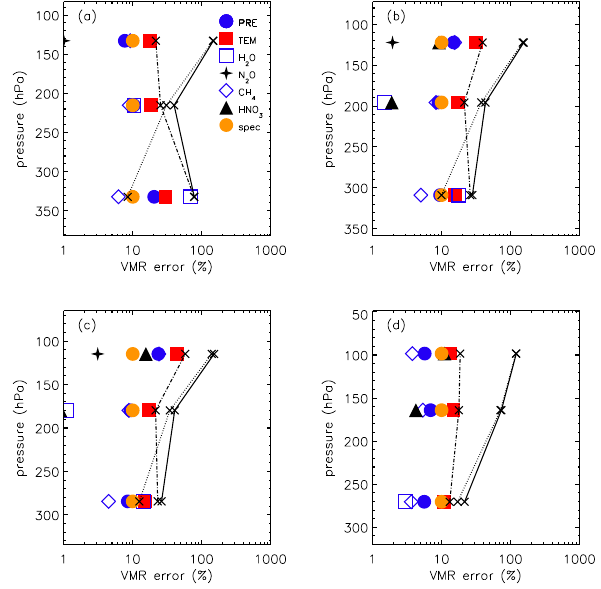
Fig. 2. Error budget for acetone VMR retrievals. The data have been split into regimes, (a) 20 ◦ S to 20 ◦ N – tropical, (b) 20 to 65 ◦ – mid-latitudes, (c) 65 to 90 ◦ in the summer hemisphere – po- lar summer, (d) 65 to 90 ◦ in the winter hemisphere – polar win- ter. The solid black line represents the total error on a single re- trieval. The random (dotted) and systematic (dashed) component of the error are also shown. Systematic errors are dominated by pressure (“PRE”) and temperature (“TEM”), acetone spectroscopy (“SPEC”), and gain uncertainties.